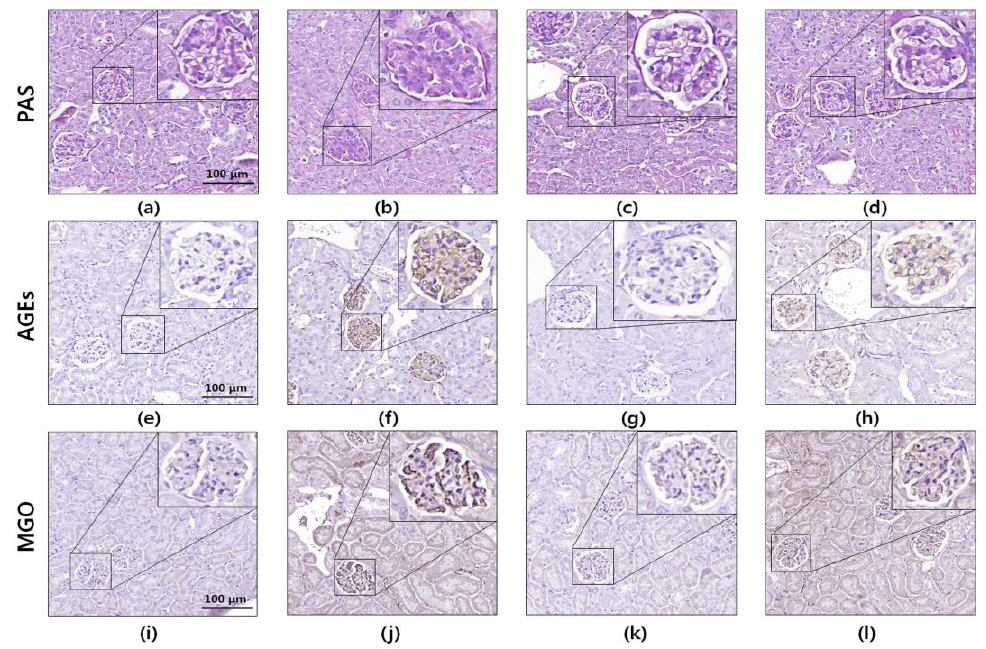
Figure 5. Periodic acid-Schiff (PAS) and immunohistochemical (IHC) staining of kidney tissues of STZ-induced diabetic mice. Representative photomicrographs of ( a – d ) PAS-stained kidney tissue; ( e – h ) immunohistochemical analysis of advanced glycation end-products (AGEs); and ( i – l ) methylglyoxal (MGO) in kidney sections from mice. The images shown are representative ( a , e , i ) normal; ( b , f , j ) STZ-induced diabetic; ( c , g , k ) aminoguanidine-treated diabetic; and ( d , h , l ) Eucommia ulmoides Oliv. (EU)-treated diabetic mouse kidney tissues. The histological sections stained with PAS and analyzed using IHC are presented at 400 × magnification.